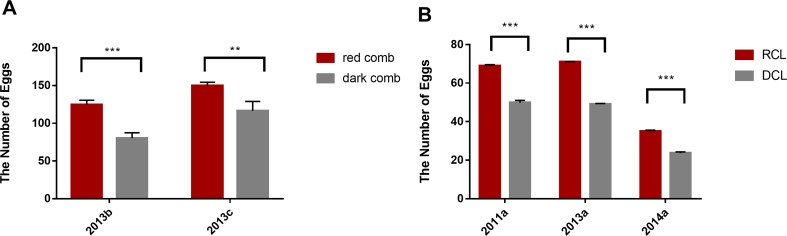
Difference in egg production between dark comb and red comb chickens during laying period. (A) Difference in the number of eggs recorded from weeks 17 to 60 obtained from an experimental farm in the China Agricultural University; The coordinate 2013b indicates the comparison between dark comb line (DCL) (N = 30) and red comb line (RCL) (N = 86); The coordinate 2013c indicates the comparison between dark comb layers (N = 48) and red comb layers (N = 14) from the random line (RAL). (B) Difference in the number of eggs in a large population (N = ∼500) in different generations (data obtained from the conservation farm of Dongxiang blue-shelled chicken); the number of eggs were recorded for 4 months (2011a, 2013a) and 2 months (2014a). The coordinates 2011a, 2013a, and 2014a indicate different generations from the conservation farm. ***p < 0.001, **p < 0.01.